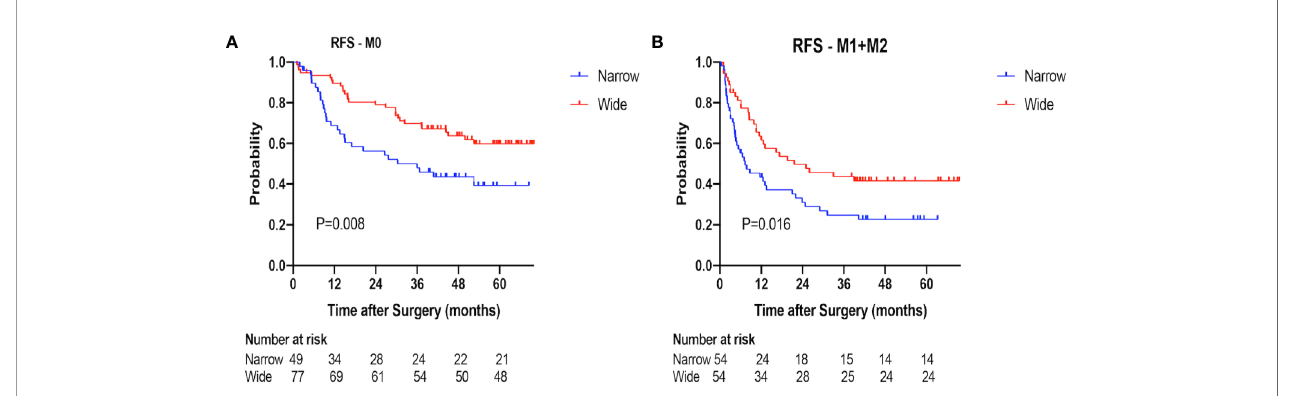
FIGURE 3 | Recurrence-free survival (RFS) of the narrow-margin and wide-margin groups strati fi ed based on microvascular invasion (MVI) status. (A) Recurrence- free survival in the subgroup of M0. (B) Recurrence-free survival in the subgroup of